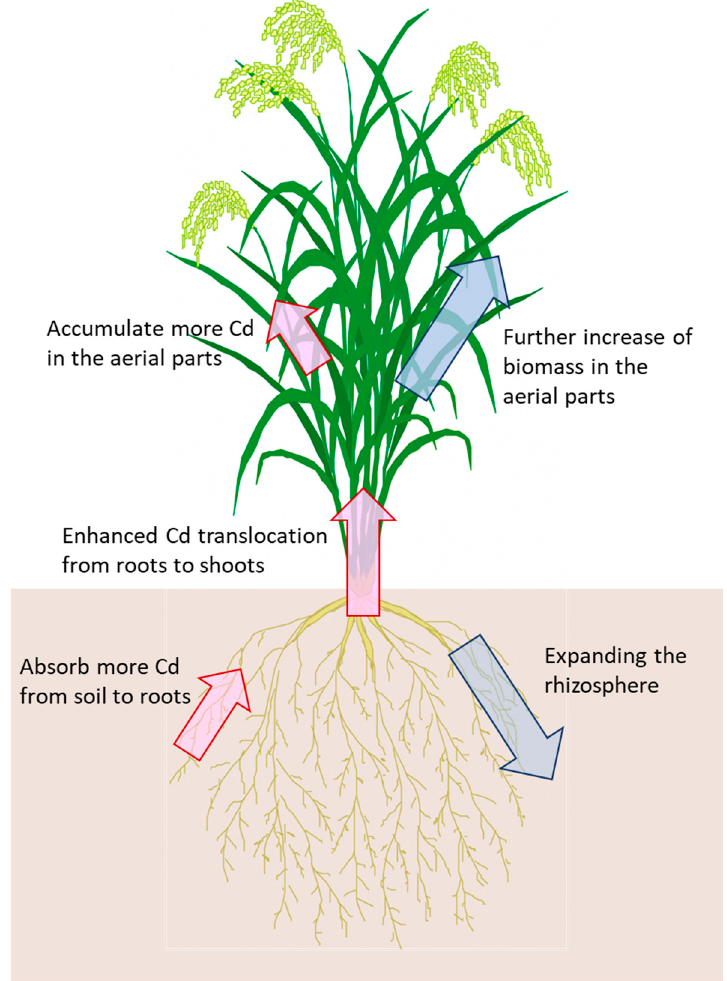
Figure 2. The breeding goals for new rice varieties of Cd phytoremediation. Blue arrows and red arrows indicate morphological and physiological improvements, respectively.